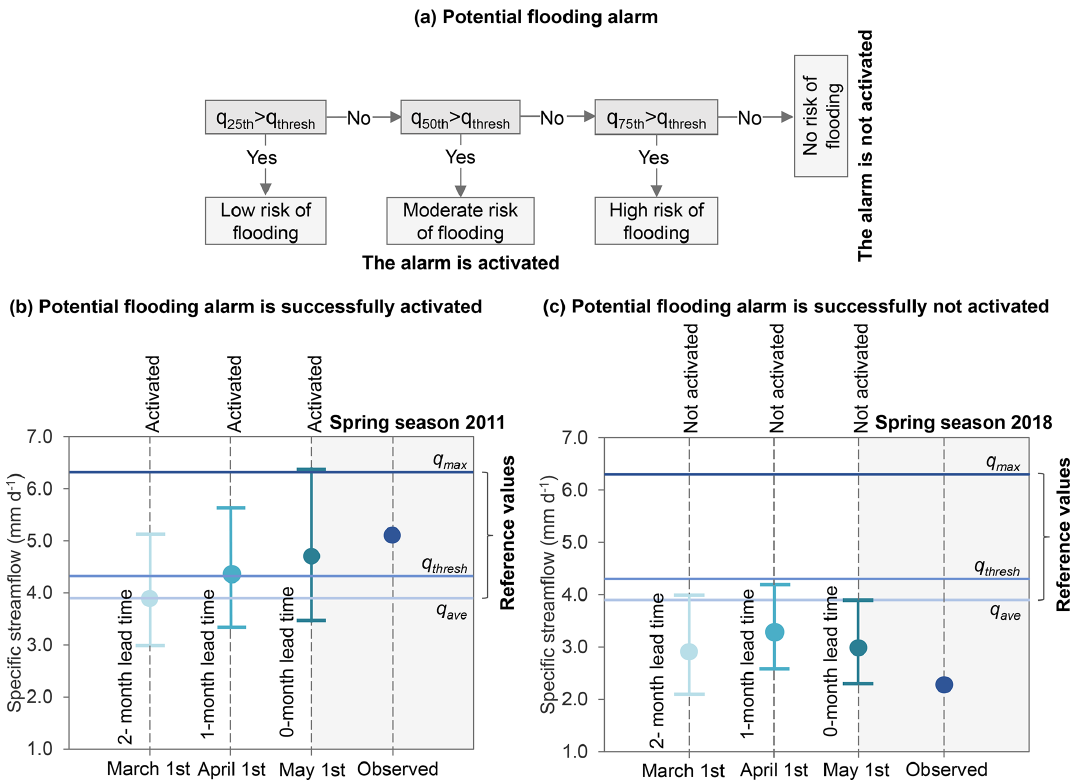
Figure 13. (a) Schematic of the potential flooding alarm system proposed. The flooding alarm is activated if q 25th > q thresh (low risk of flooding), q 50th > q thresh (moderate risk of flooding), or q 75th > q thresh (high risk of flooding). Otherwise, the alarm is not activated. (b) Average projections of spring maximum specific streamflow of UCRB for 2011 when flooding is successfully activated, and (c) average projections of spring maximum specific streamflow of UCRB for 2018 when flooding is successfully not activated. Average projections at 0-, 1-, and 2-month lead times correspond to dark turquoise, turquoise, and light turquoise, respectively. The blue point corresponds to the observed specific streamflow for 2018, horizontal lines correspond to the observed highest specific streamflow ( q max ; dark blue), observed flooding threshold specific streamflow ( q thresh ; blue), and observed average specific streamflow ( q ave ; light blue). For each lead time, the whiskers show the first and third quartile ( q 25th and q 75th ), and the points show the median or second quartile ( q 50th